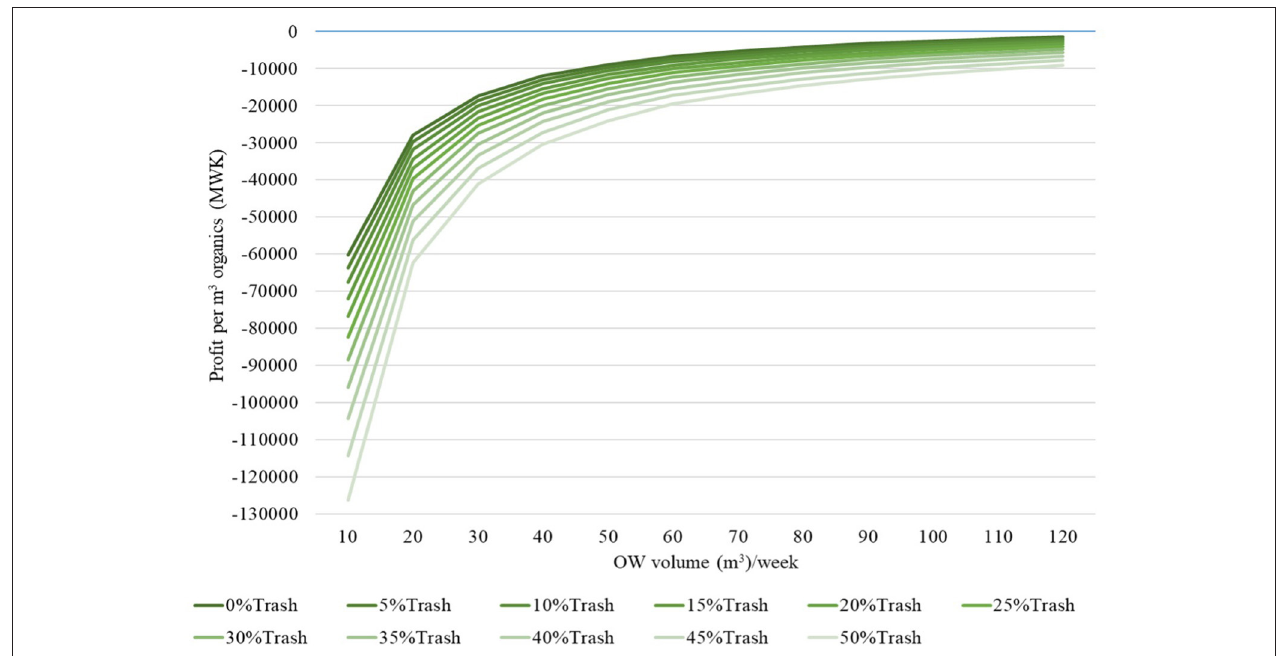
FIGURE 3 | Profitability as a function of plastic contamination at baseline model situation (capital expenditure